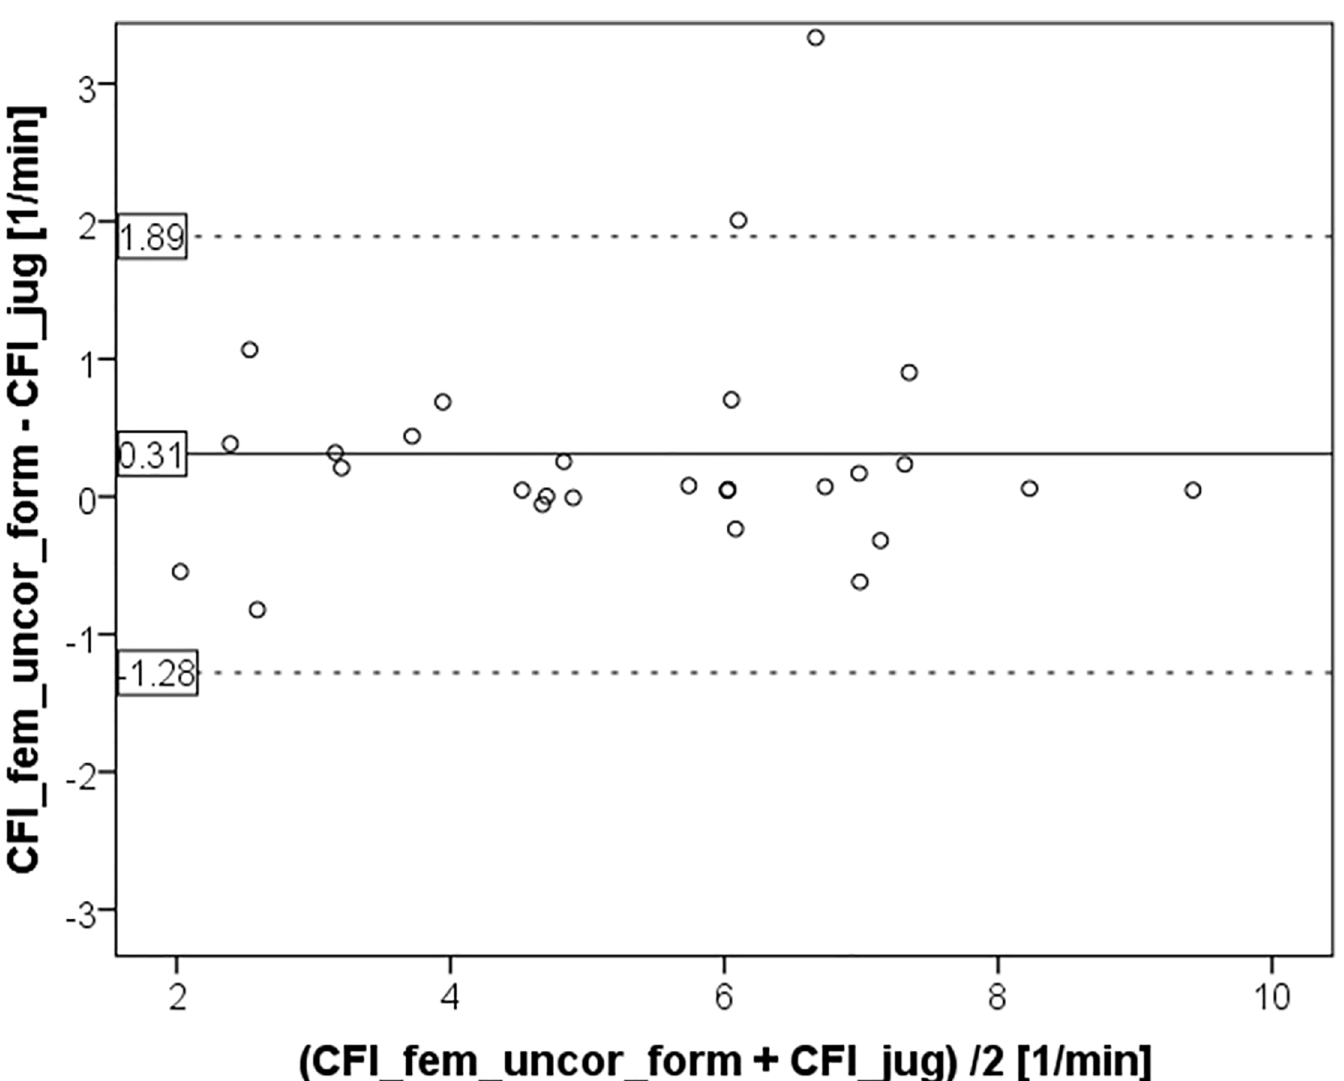
Fig 5. Bland Altman plot comparing cardiac function index CFI_jug derived from jugular indicator injection to cardiac function index CFI-fem_uncor_form which was derived from femoral indicator injection without activation of a potential correction by the device, but corrected with the formula suggested for correction of femoral indicator injection derived global end-diastolic volume index GEDVI: GEDVI corrected [mL / m 2 ] = 0.539 (cid:3) GEDVI uncorrected —15.17 + 24.49 (cid:3) CI uncorrected 2.311 (cid:3) BW ideal. CFI_fem_uncor_form was calculated by multiplying CFI_fem_uncor with the ratio GEDV uncorrected /GEDV corrected . GEDV(I): global end-diastolic volume (index). CI: Cardiac index.